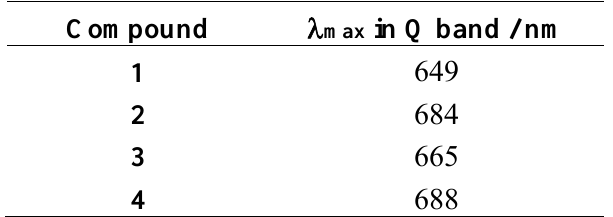
Table 2. Absorption maximum of Q band in UV-Vis spectrum of cobalt phthalocyanine